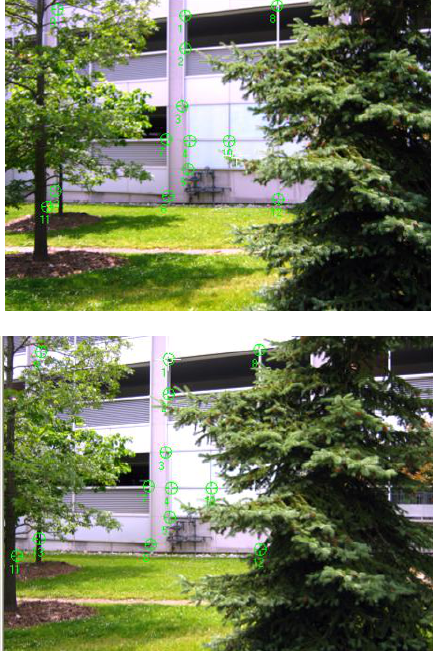
Figure 7. Directly geoferenced stereopair and check